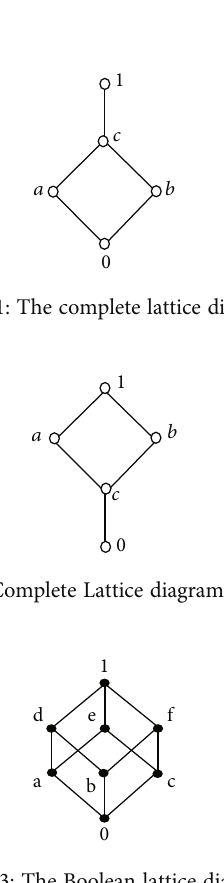
Figure 4: The chain 4